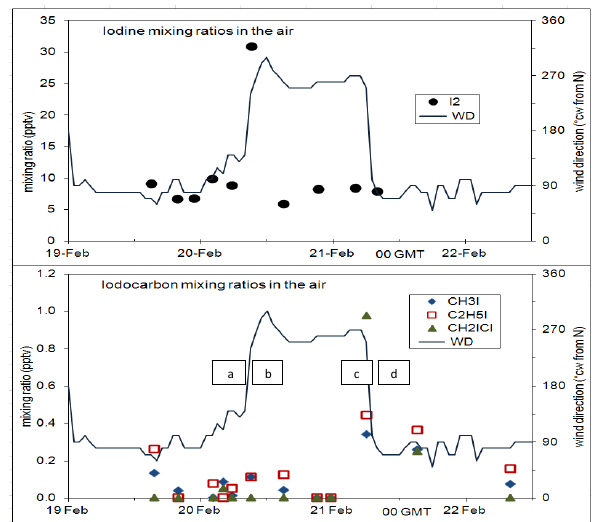
Fig. 11. Atmospheric I 2 (top panel) and iodocarbon (bottom panel) concentrations with corresponding wind direction. Ozone concentration was between 20 and 25 ppbv throughout the period. Back trajectories ending at the times of the letters are shown in Figure 12. Back trajectories for the 12 hours previous to (a) and (c) were from similar directions to those of (a) and (c).